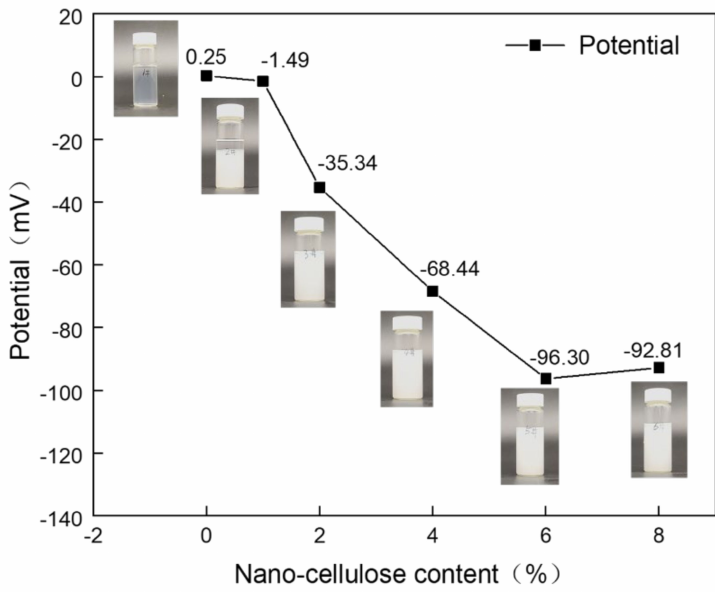
Figure 1. Zeta potential of spinning solutions with different NC mass ratios.